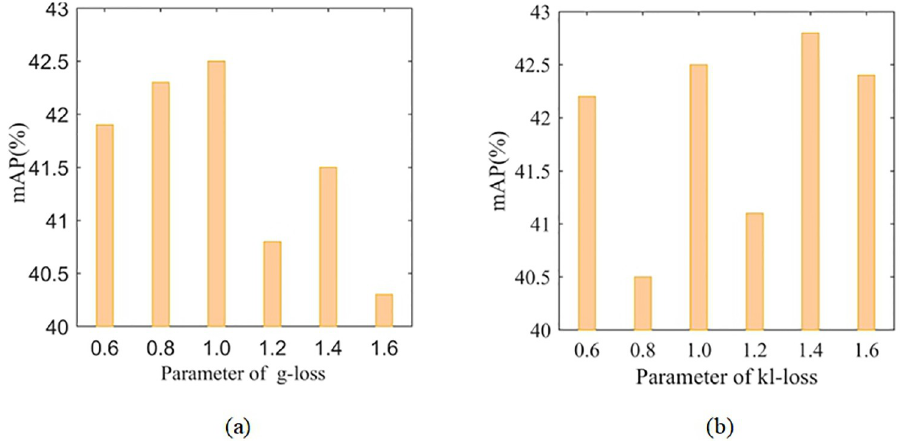
Fig 6. Parameter analysis: (a) shows L g in the total loss, the influence of different weights on the total loss, and the weight is recorded as λ 1 ; (b) shows L w weight is recorded as λ 2